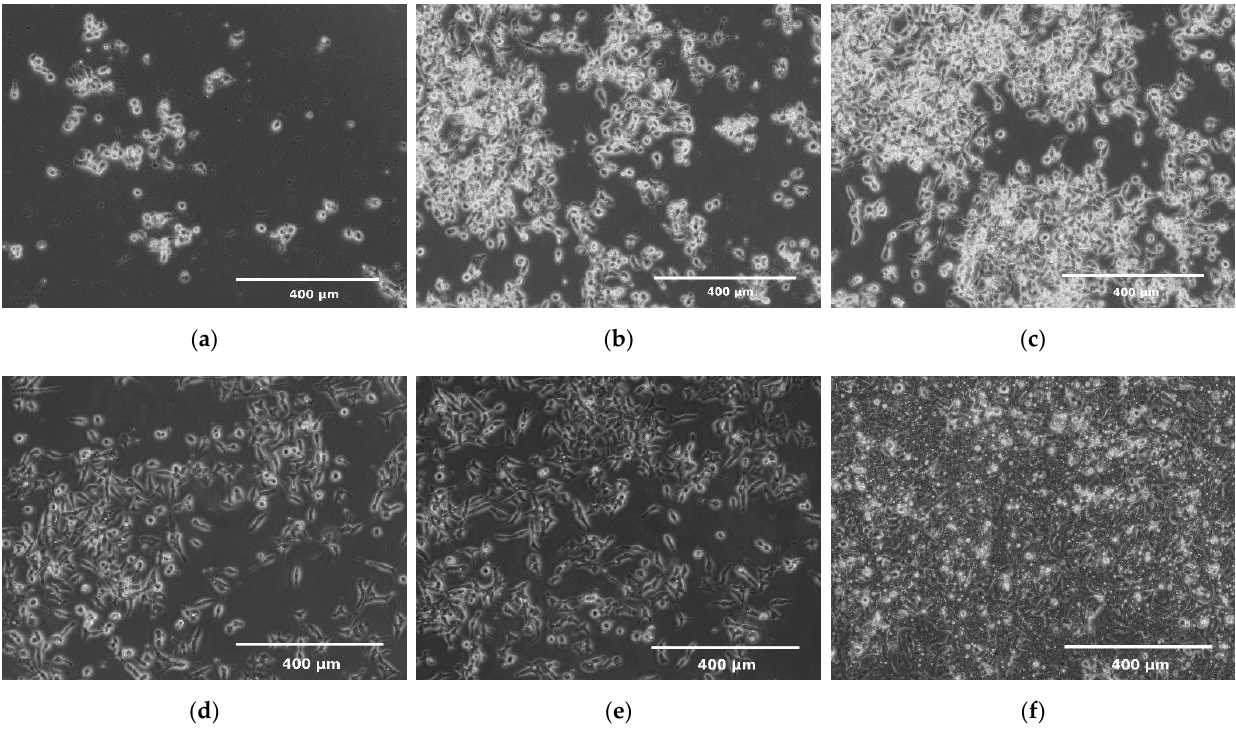
Figure 4. Setting the gradient of the active and indicator substances: ( a ) a—removing solutions from reservoirs, b—adding 14 μL of fluids, c—filling up the culture chambers, d—emptying excess fluids from the reservoirs; ( b ) a—addition of 5 μL of the complete medium, b—setting of gradients, c—emptying the reservoirs from the liquid.